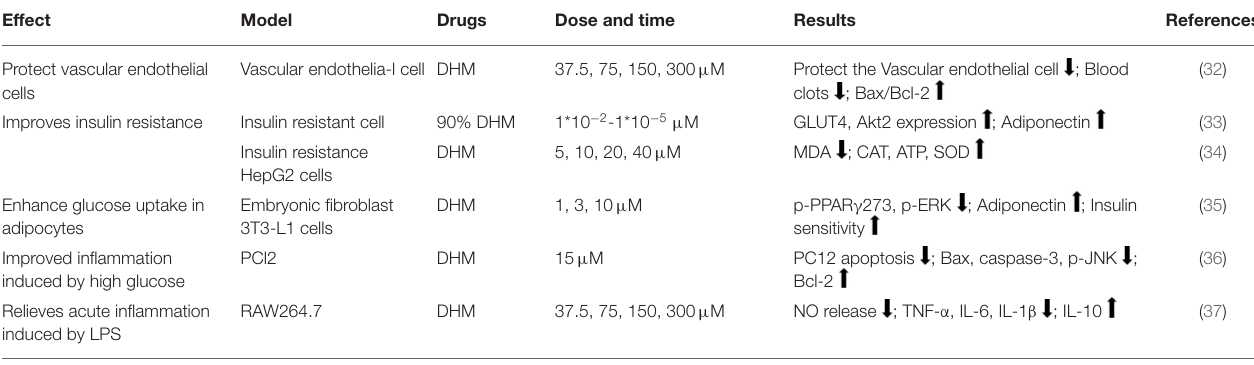
TABLE 1 | The effect and molecular mechanism of DHM on MS in cell